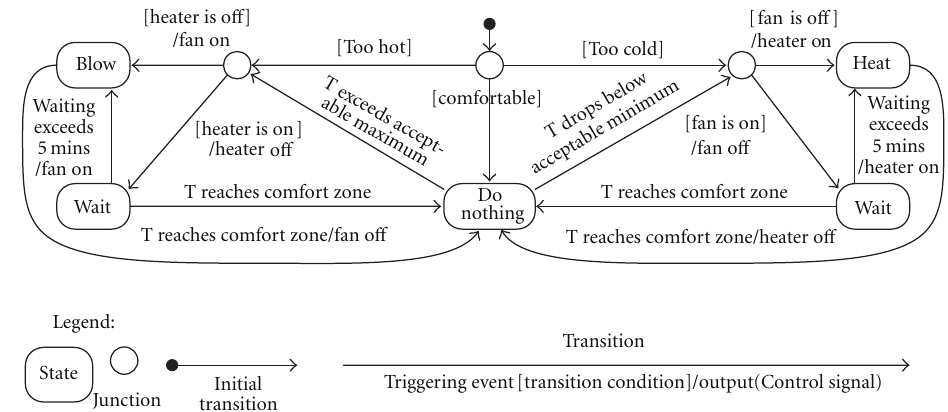
Figure 5: Example of a simple state machine: statechart of embedded control in a heating/cooling